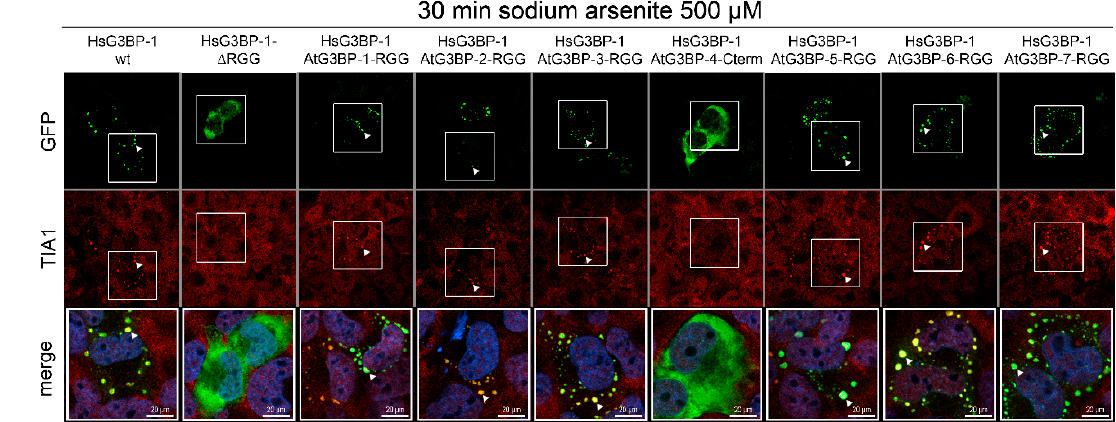
Figure 4. RG/RGG domain exchange. The indicated EGFP::G3BP constructs were expressed in HsG3BP1/2 − / − U2OS cells and treated with 500 µM SA for 30 min to induce SG formation. The cells were then fixed and stained for TIA-1 (red) and DNA (blue in the merged channel).